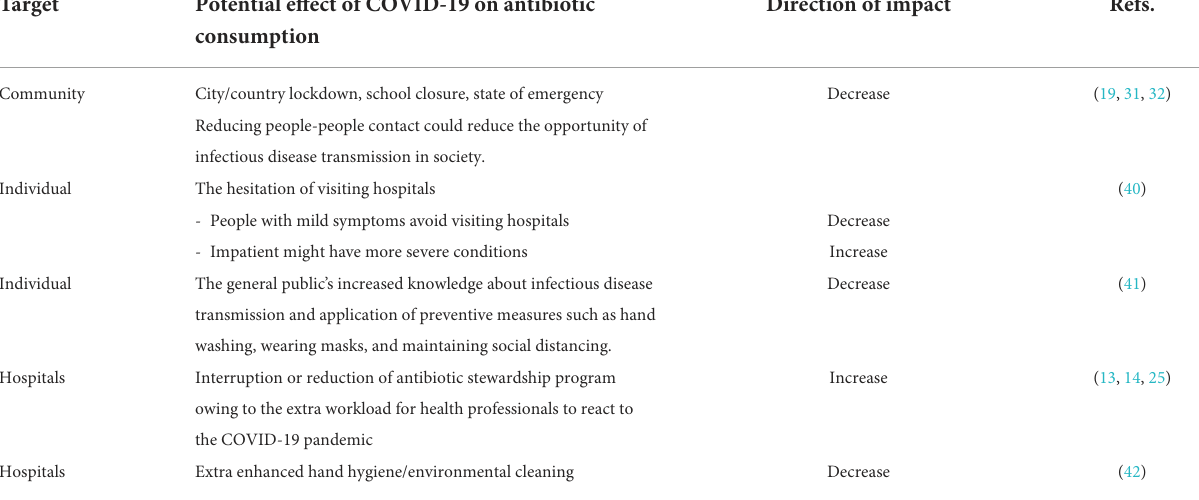
TABLE 1 Summary of potential effect of the COVID-19 pandemic on health systems, society, and personal attitude/knowledge that could influence antibiotic consumption (increase or